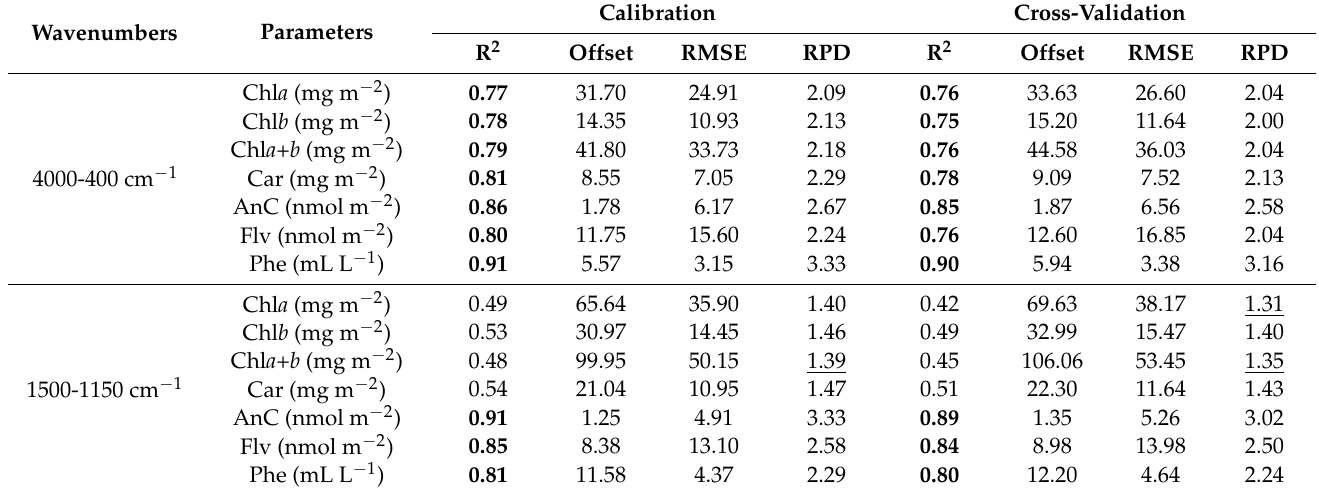
Table 2. PLSR model in calibration and cross-validation at wavenumbers of 4000 at 400 cm − 1